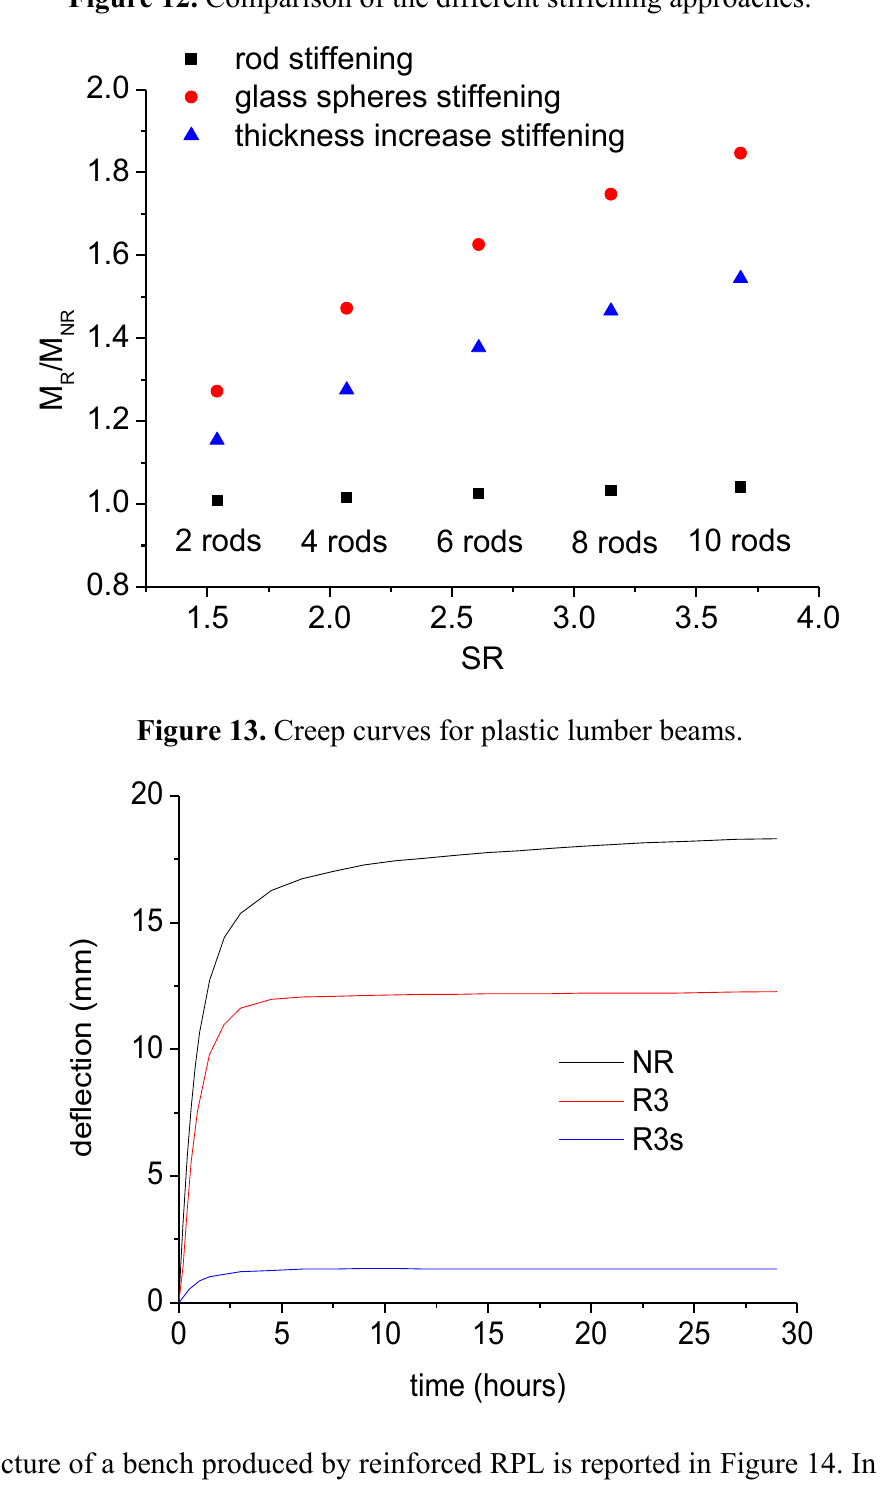
Figure 12. Comparison of the different stiffening approaches.